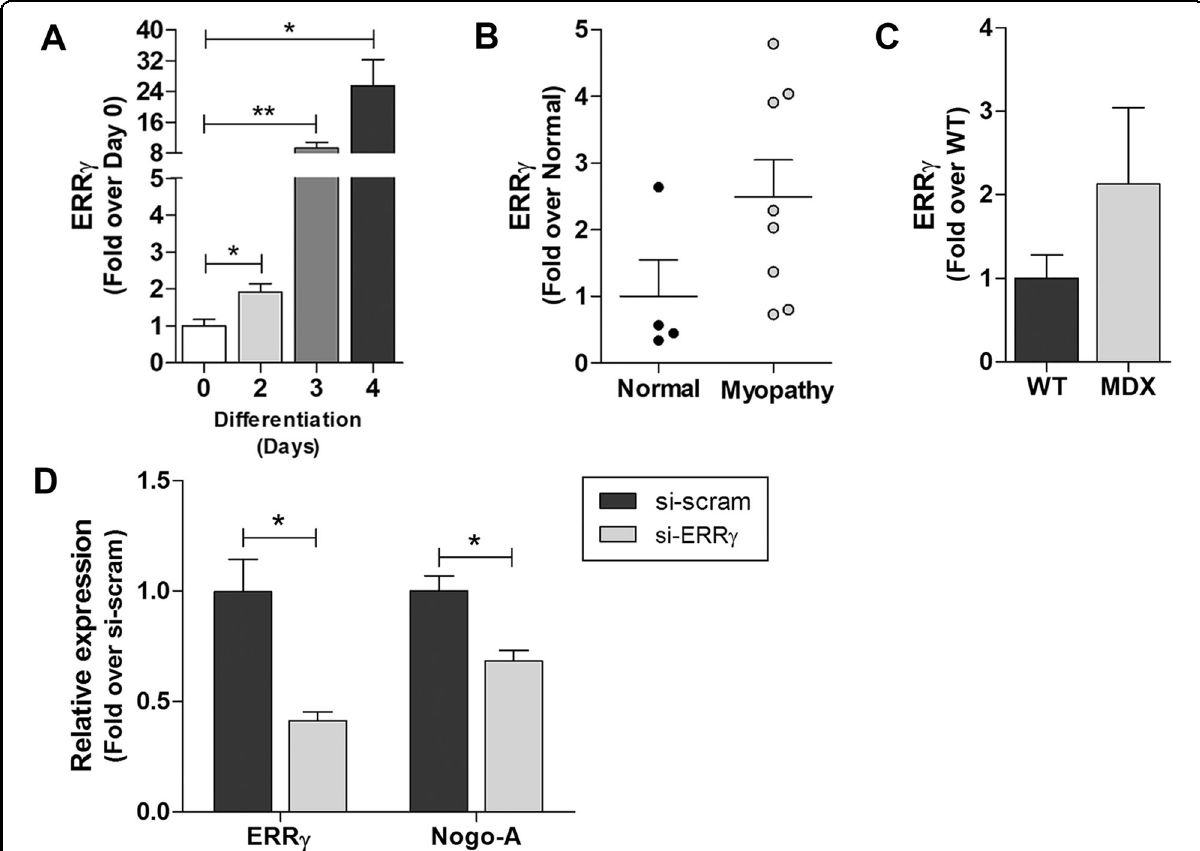
Fig. 5 Expression of ERR γ in differentiated C2C12 cells and dystrophic muscles, and Nogo-A expression in ERR γ -silenced C2C12 cells. A – C qRT-PCR analysis of ERR γ during differentiation of C2C12 cells with DM ( A ), in normal ( n = 4) and myopathic ( n = 8) human muscle tissues ( B ), and of muscles from WT ( n = 4) and mdx ( n = 4) mice ( C ). D qRT-PCR analysis of si-scrambled- or si-ERR γ -transfected C2C12 cells ( n = 3/group). Mean ± SEM. * p <